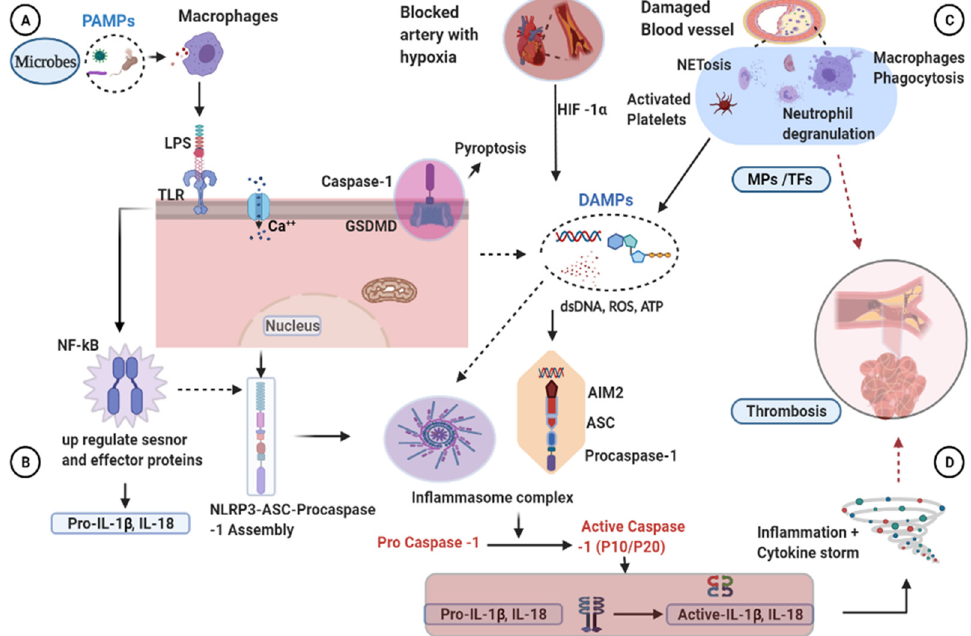
Figure 1. Mechanisms of inflammasome activation and clot formation. ( A , B ) TLR detects the presence of microbes (LPS) and activates the NF-kB that initiates the priming phase by transcribing the pro-IL-1 β . Then, coupled with endogenous signals, the inflammasome components will be assembled and activate the procaspase-1. ( C ) Blood vessel damage, activated platelets, and hypoxia-inducible factors have been shown in thrombosis activation. Macrophages and neutrophils migrate and release their danger signals to the damaged vessels, including ROS, ATP, and dsDNA, contributing to the development of inflammasome complexes. Activated caspase-1 in turn activates pro-IL-1 β and IL-18. Active caspase-1 further activates the GSDMD transmembrane protein associated with membrane pore formation, destabilization, and cell membrane rupture (pyroptosis). Inflammation and pyroptosis are enhanced by activated caspase-1, leading to thrombosis. AIM2, after sensing the dsDNA released from the pyroptotic cells, will form inflammatory complexes and cleave the procaspase-1 to become the active caspase-1. MPs derived from activated cells contain TFs, which initiate the coagulation system and cause blood clot formation. ( D ) Activated proinflammatory cytokines increase inflammation and cause cytokine storms and induce blood clotting. AIM2, absent in melanoma 2; ATP, adenosine triphosphate; Ca, calcium; ASC, apoptosis-associated speck-like protein containing a caspase recruitment domain; DAMPs, damage-associated molecular patterns; dsDNA, double stranded deoxyribonucleic acid; GSDMD, Gasdermin D; HIF-1 α , hypoxia inducible factor one alpha; IL-1 β , Interleukin 1 beta; IL-18, Interleukin18; LPS, lipopolysaccharide; MPs, microparticles; NET, neutrophil extracellular trap; NF-kB, nuclear factor kappa light chain stimulation of activated B cells; NLRP3, nucleotide-binding oligomerization domain, leucine-rich repeat, and pyrin domain containing 3 protein; PAMPs, pathogen-associated molecular patterns; ROS, reactive oxygen specious; TFs, tissue factors; TLR, toll-like receptor.